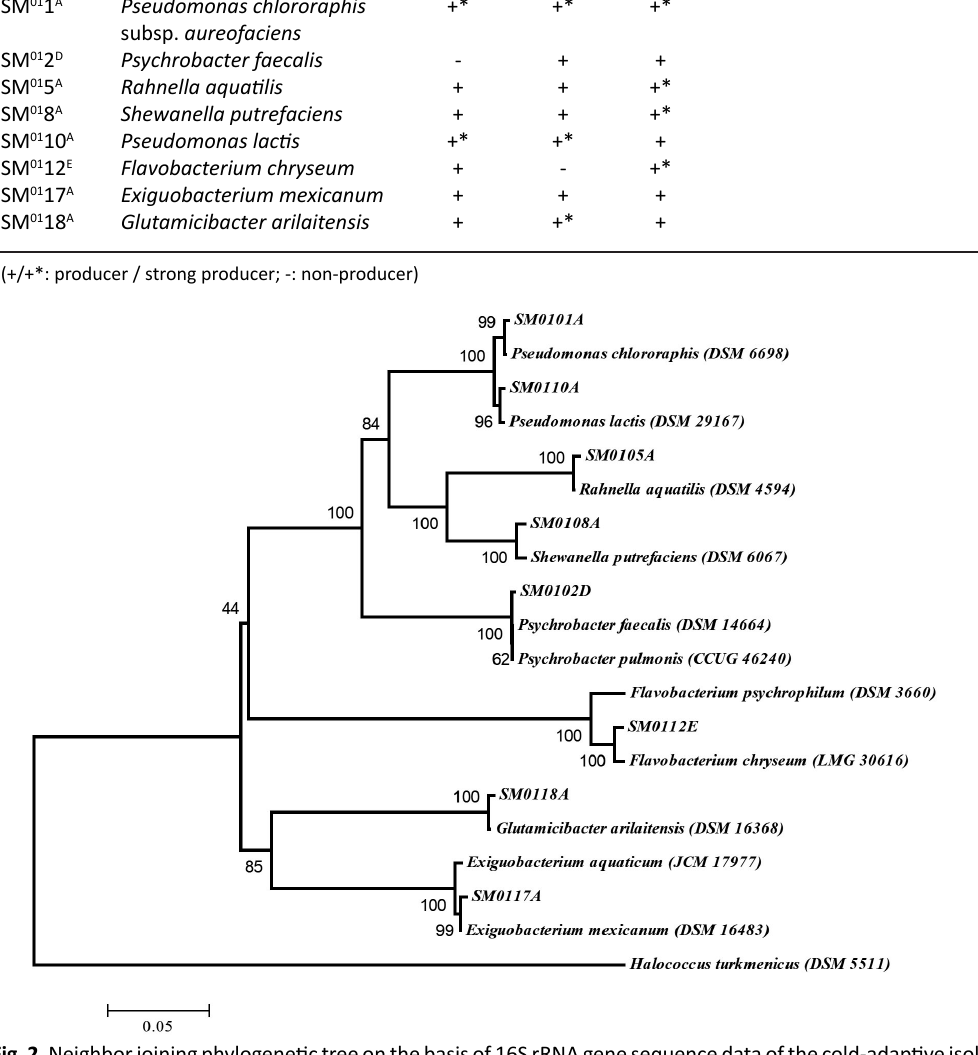
Fig. 2. Neighbor joining phylogenetic tree on the basis of 16S rRNA gene sequence data of the cold-adaptive isolates in Turkey. Halococcus turkmenicus was used as out-group. Bootstrap values based on 1000 replications are listed as percentages at branching points. The accession numbers are given in parentheses. The scale bar represented 5%